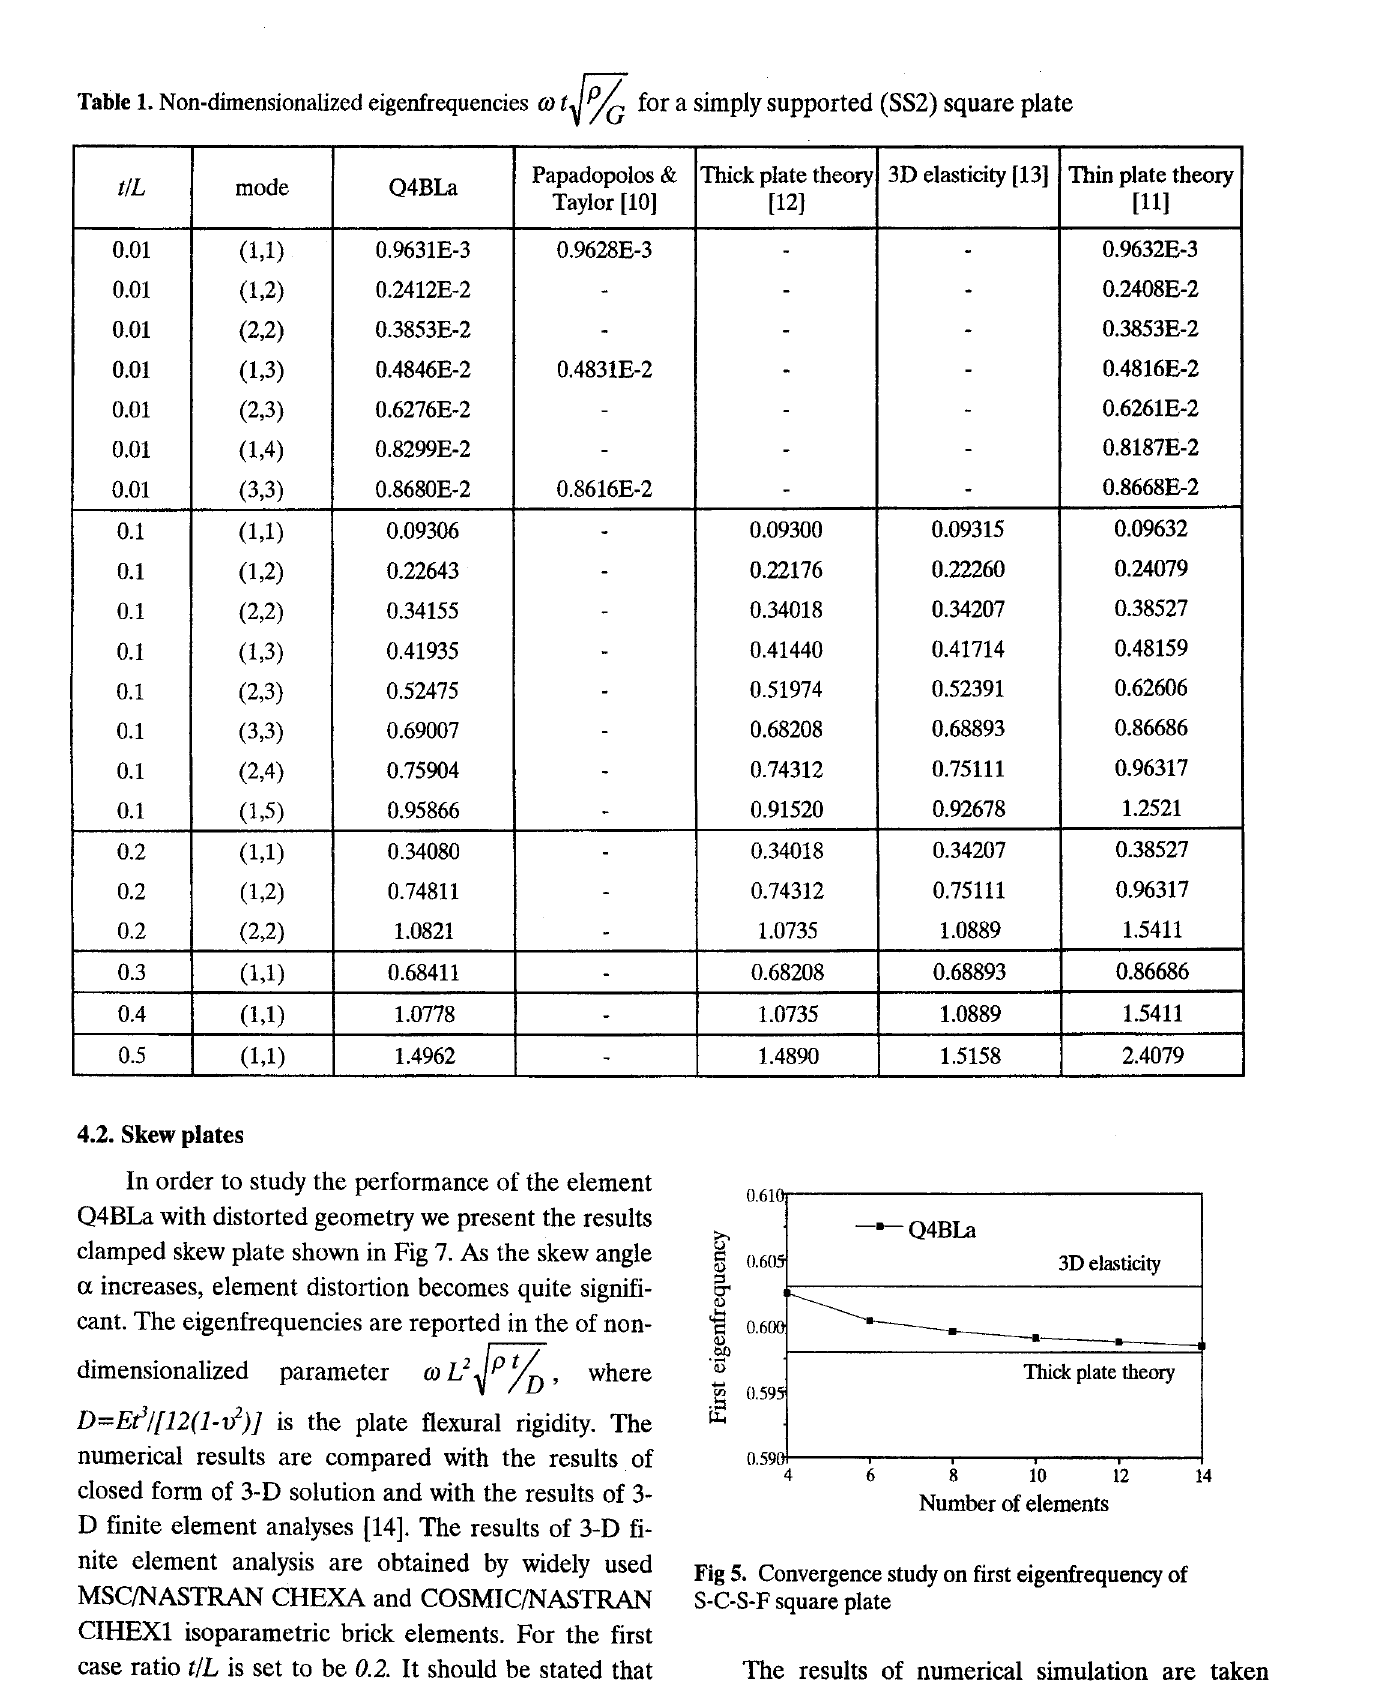
Fig 5. Convergence study on first eigenfrequency of S-C-S-F square plate The results of numerical simulation are taken from (14x14) mesh size. The study how eigenfrequen cies vary with the skew angle a increasing from 0° to 45° is presented in Figs